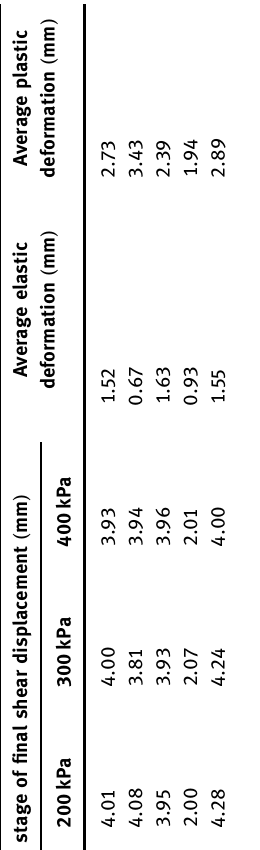
the average elastic deformation of the test piece with 0.5% straw under di ff erent vertical pressures was obtained as 0.67 mm, 55.92% less than that of the pure yellow mud test piece, and the average plastic deformation was measured as 3.28 mm, 34.43% more than that of the pure yellow mud test piece. The average elastic deformation of the specimen with 5% starch under di ff erent vertical pressures was obtained as 1.63 mm, 7.24% higher than that of the pure yellow mud specimen, and the average plastic deforma - tion was 2.39 mm, 12.45% lower than that of the pure yellow mud specimen. The average elastic deformation of the specimen with 11% cement under di ff erent vertical pressures measured 0.93 mm, 38.82% less than that of the pure yellow mud specimen, and the average plastic defor - mation was found as 1.94 mm, 28.93% less than that of the pure yellow mud specimen. The average elastic deforma - tion of the specimen with 7% epoxy resin under di ff erent vertical pressures was found as 1.55 mm, 1.97% higher than that of the pure yellow clay specimen, and the average plastic deformation was obtained as 2.89 mm, 5.86% higher than that of the pure yellow clay specimen.